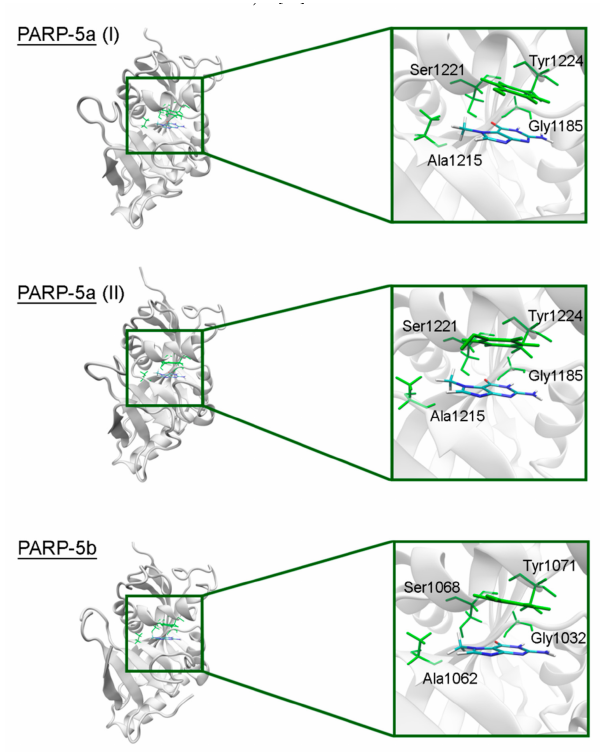
Figure 4. 7-MG position in the NA binding site of PARP-5a (conformations I and II) and 5b obtained using MD modeling. The NA site residues are colored in